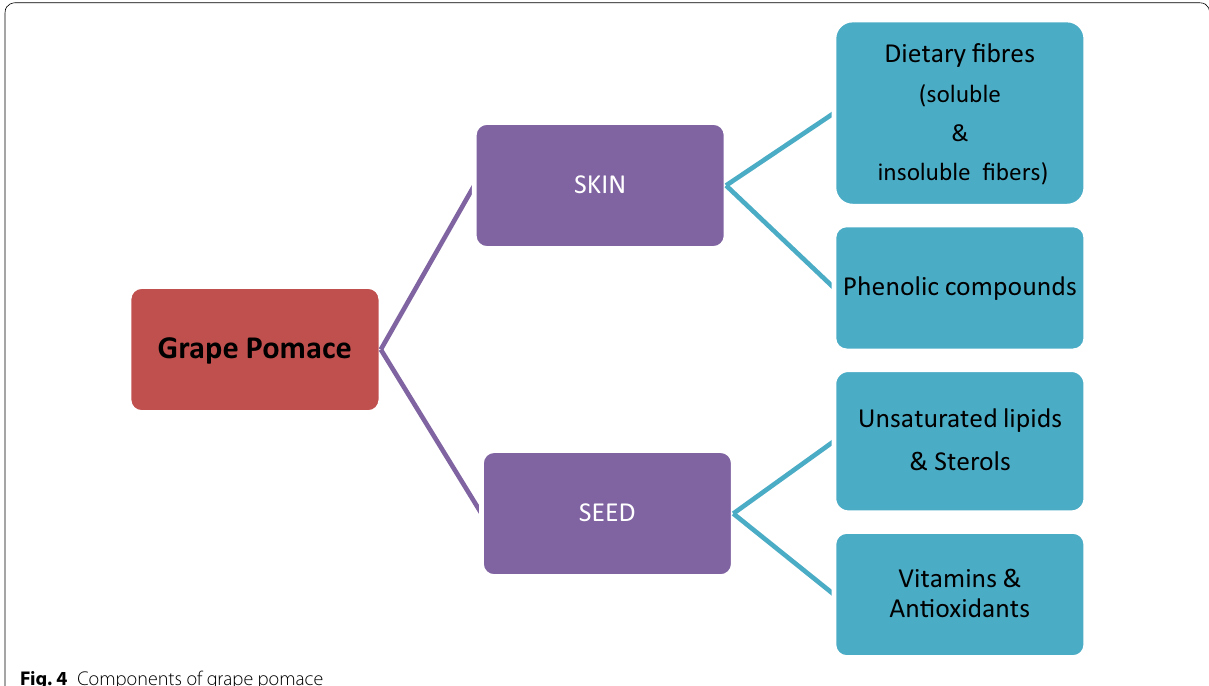
Fig. 4 Components of grape